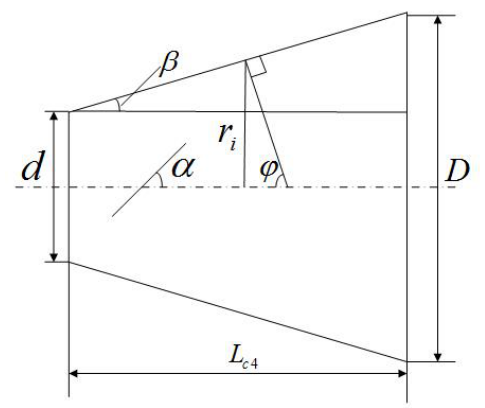
Figure 7: The sketch of cone of the head of gasbag